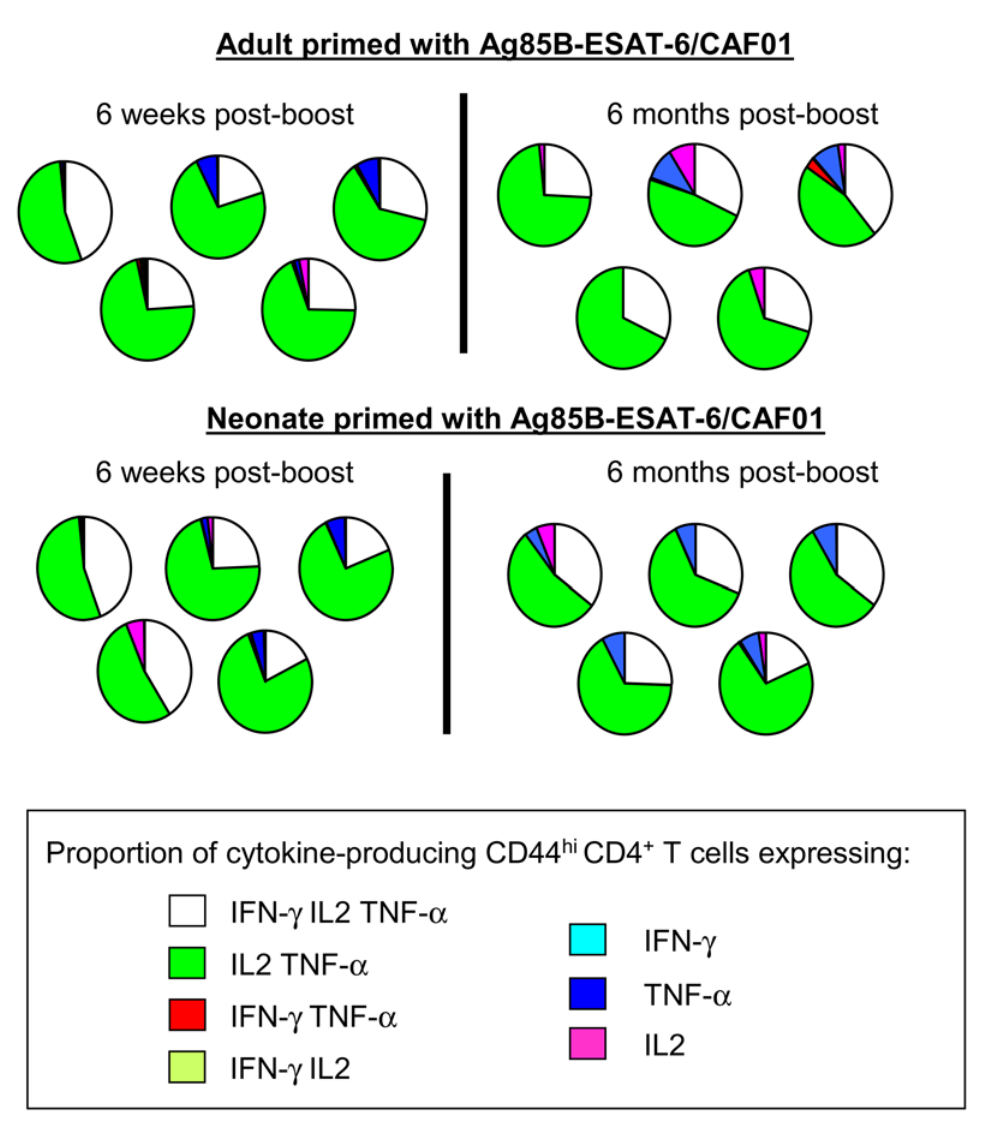
Figure 3. Ag85B-ESAT-6/CAF01 stimulates production of multifunctional CD4 + T cells in neonates and adults. The expression of IFN- c , IL-2 and TNF- a was determined by ICS on splenocytes from neonatal and adult mice, 6 weeks and 6 months post-boost. Cytokine production was only detected in CD4 + T cells from Ag/CAF01-immunized mice stimulated with antigen. The concurrent expression of IFN- c , IL-2 and TNF- a is represented as pie graphs of cytokine expression by CD4 + CD44 + T cells of individual mice, and is representative of 2 independent